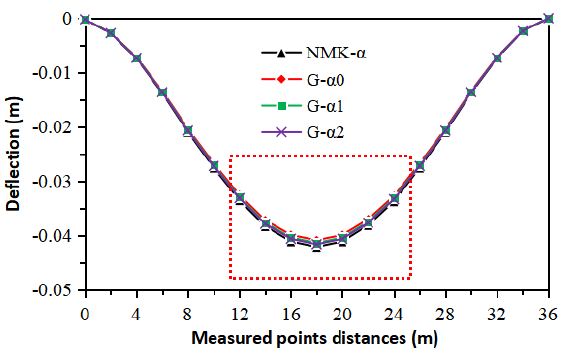
Figure 12. Comparison of the deflection results between the NMK- α and G - α methods.